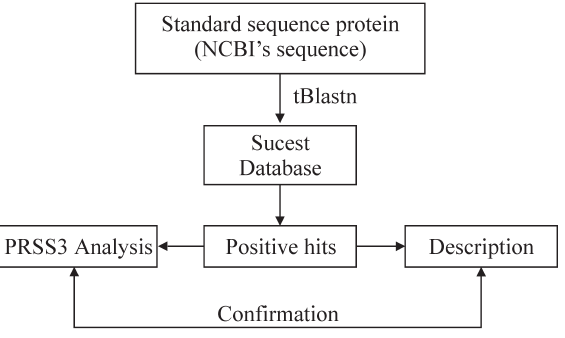
Figure 2 - Schematic representation of the search strategy. Sequences representative of each of the eleven proteins participating in the purine synthesispathwaywereselectedfromNCBI(NationalCenterforBiotech- nology Information) database. Those peptide sequences were used to screen the sugarcane expressed sequence tag (SUCEST) database using the tBLASTn program. The positive hits were further confirmed by the PRSS3 implementation of the Monte Carlo shuffling algorithm, resulting in a table of statistically significance